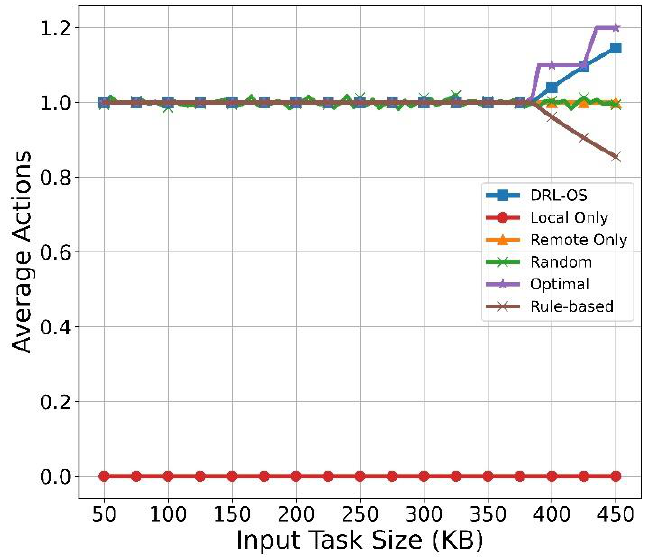
Figure 8. Task average action vs. input size.